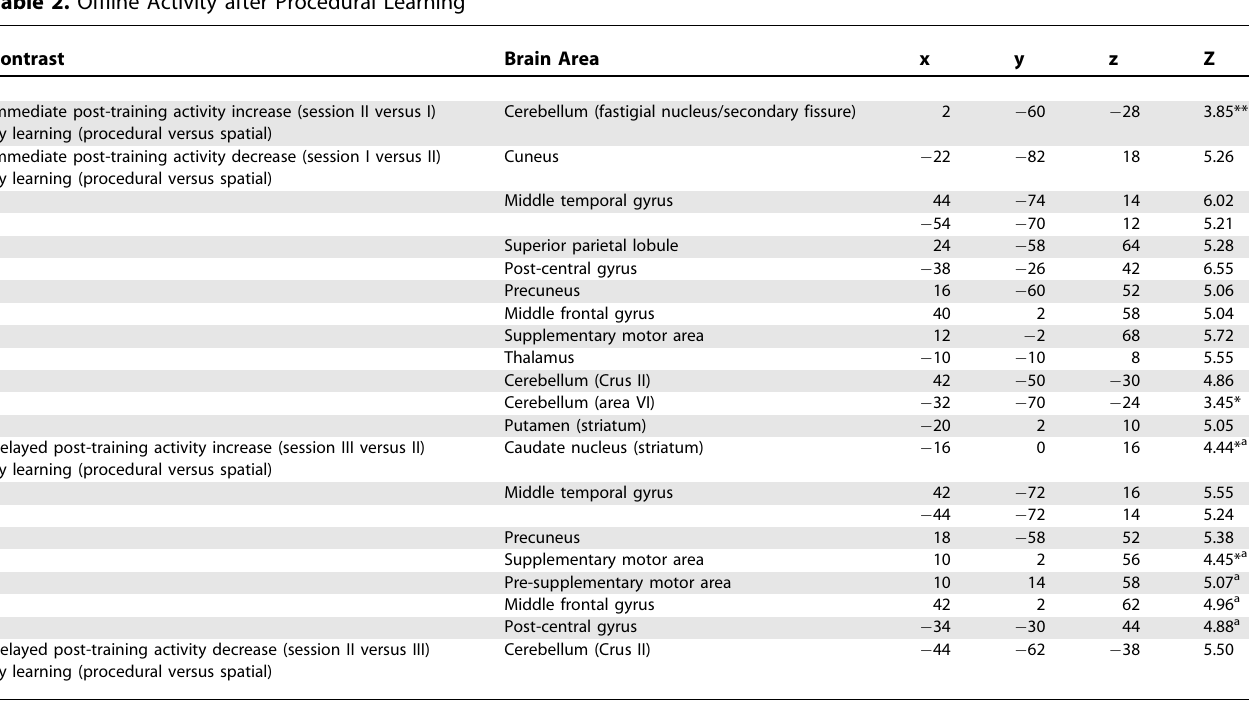
Table 2. Offline Activity after Procedural Learning Contrast Brain Area